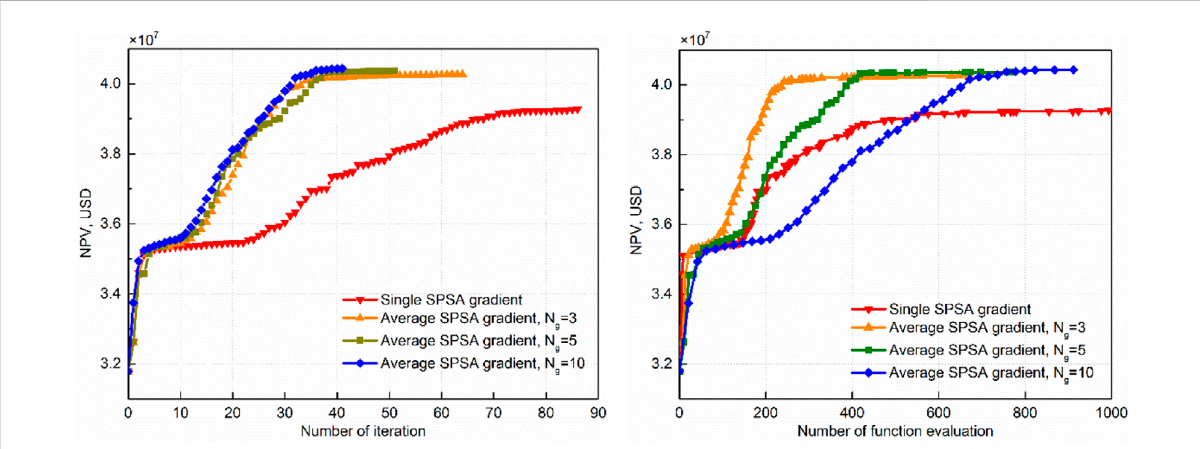
FIGURE 4 Iteration of the objective function for the synthetic model. Left: NPV as a function of iteration number; Right: NPV as a function of objective function evaluation